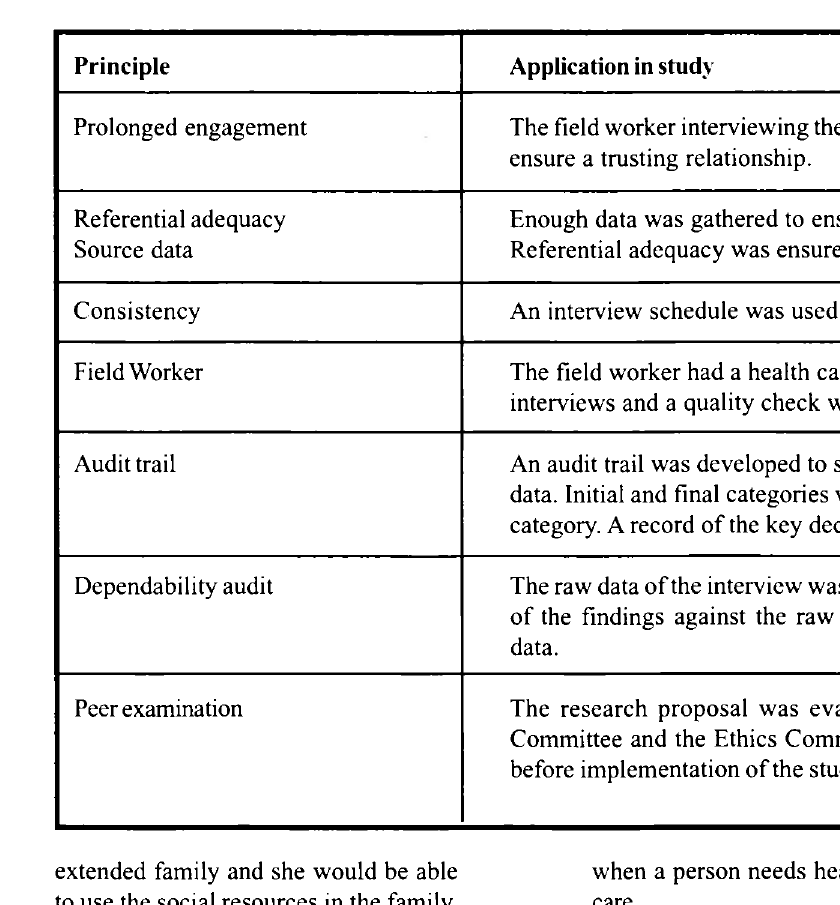
Principle Application in study Prolonged